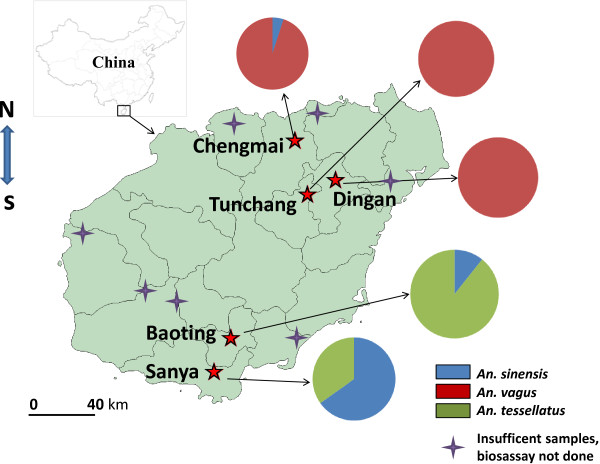
A map of Anopheles mosquito sampling sites in Hainan Island, China. Pie chart shows the species composition.